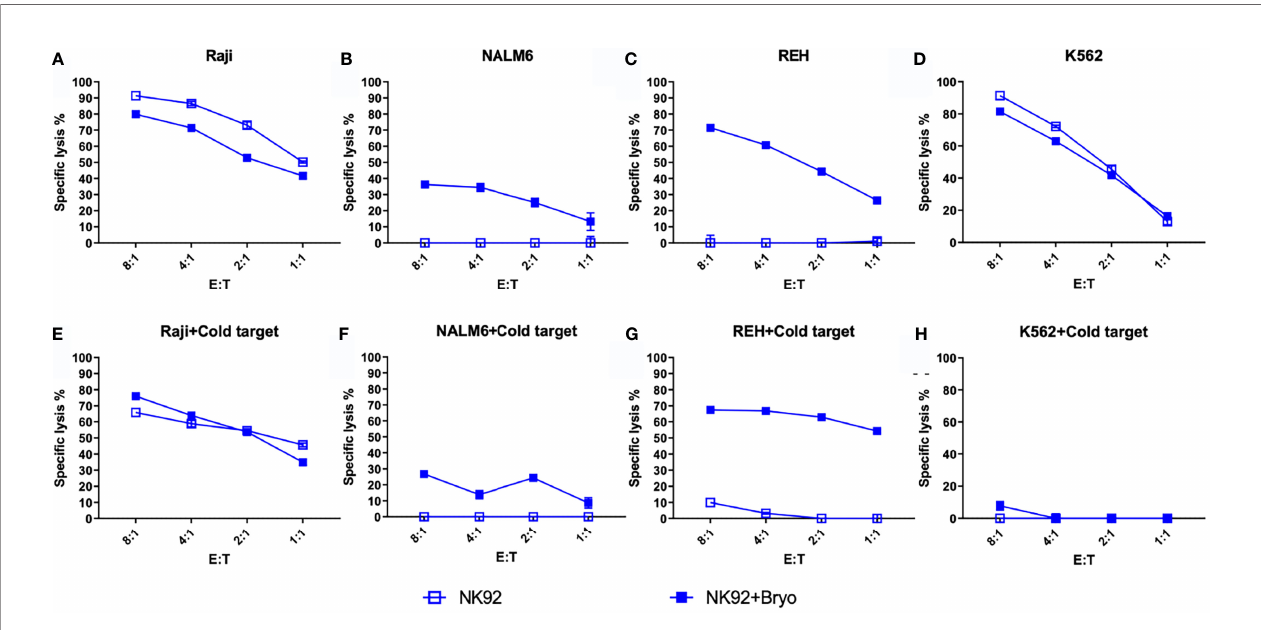
FIGURE 7 | NK92-mediated cellular cytotoxicity of bryostatin-treated leukemia. (A – D) Average lysis from triplicate wells for four cell lines (Raji, NALM6, REH, K562) mediated by NK92 cells using untreated (open square) or bryostatin-treated (closed square) targets at the E:T ratios listed on the x-axis. (E – H) Assay tested in parallel including cold-target inhibition. Representative results, average of triplicate wells and standard deviation, from 3 independent experiments are